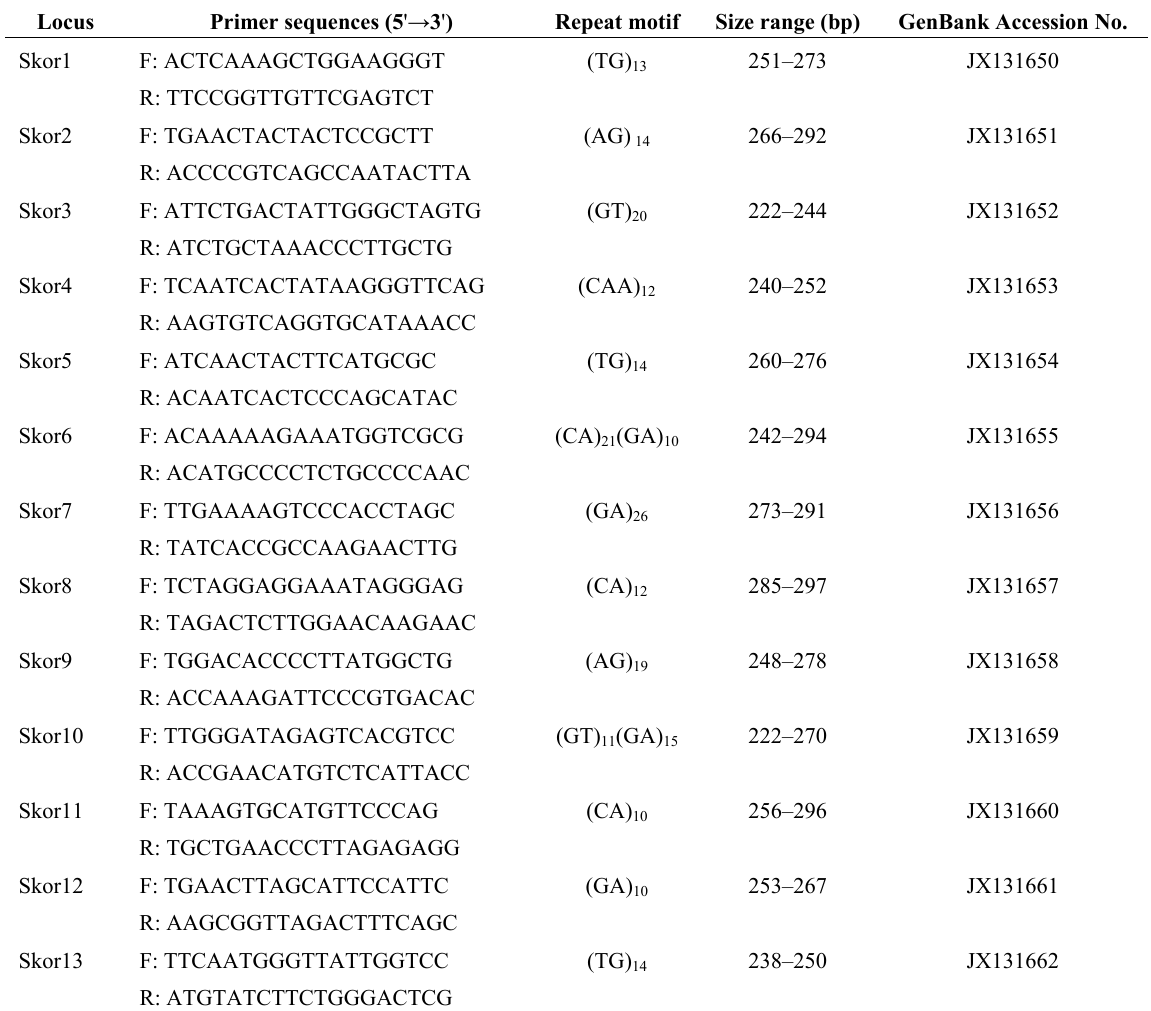
Table 2. Characteristics of 13 microsatellite markers developed in Sophora koreensis .